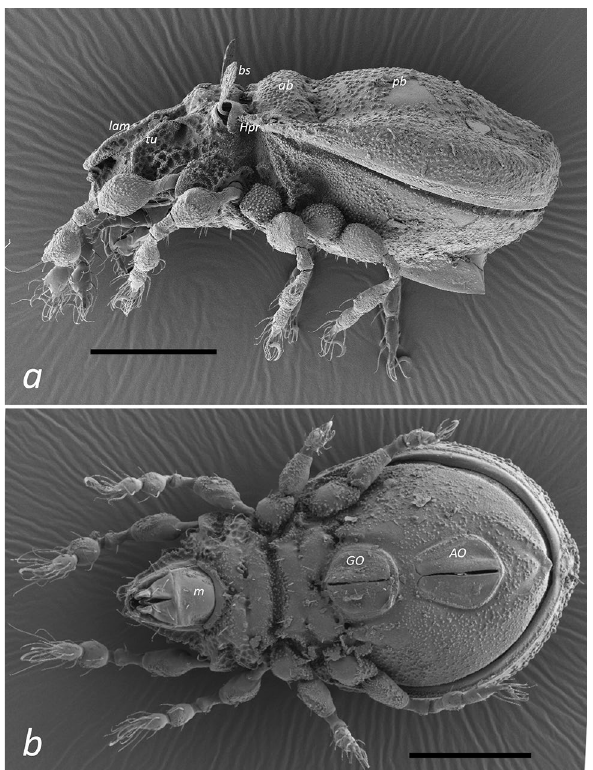
Figure 3. SEM micrographs of ( a ) Caleremaeus mentobellus (lateral) and ( b ) C. hispanicus (ventral). lam = lamella, tu = tutorium, bs = bothridial seta, Hpr = humeral process, ab = transverse anterior bulge of notogaster, pb = longitudinal posterior bulge of notogaster, m = mentum, GO = genital orifice, AO = anal orifice; scale bars = 100